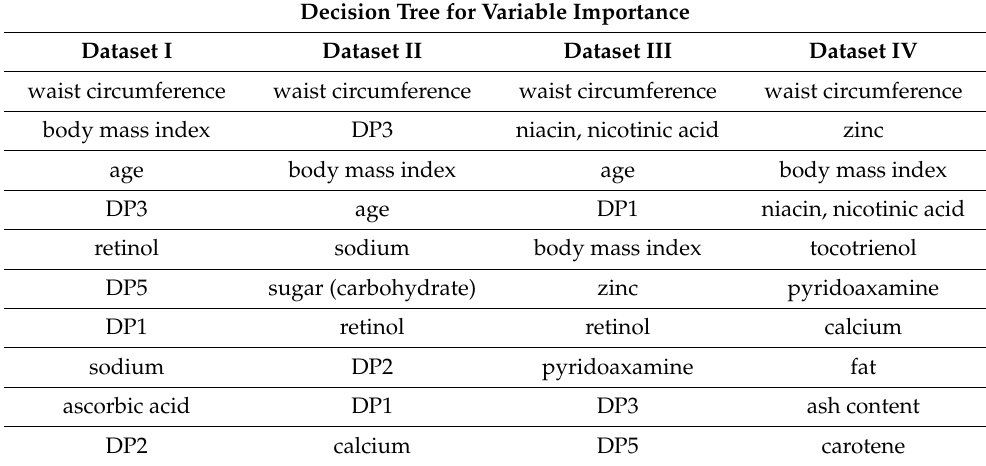
Table 6. Top 10 variable importance in decision